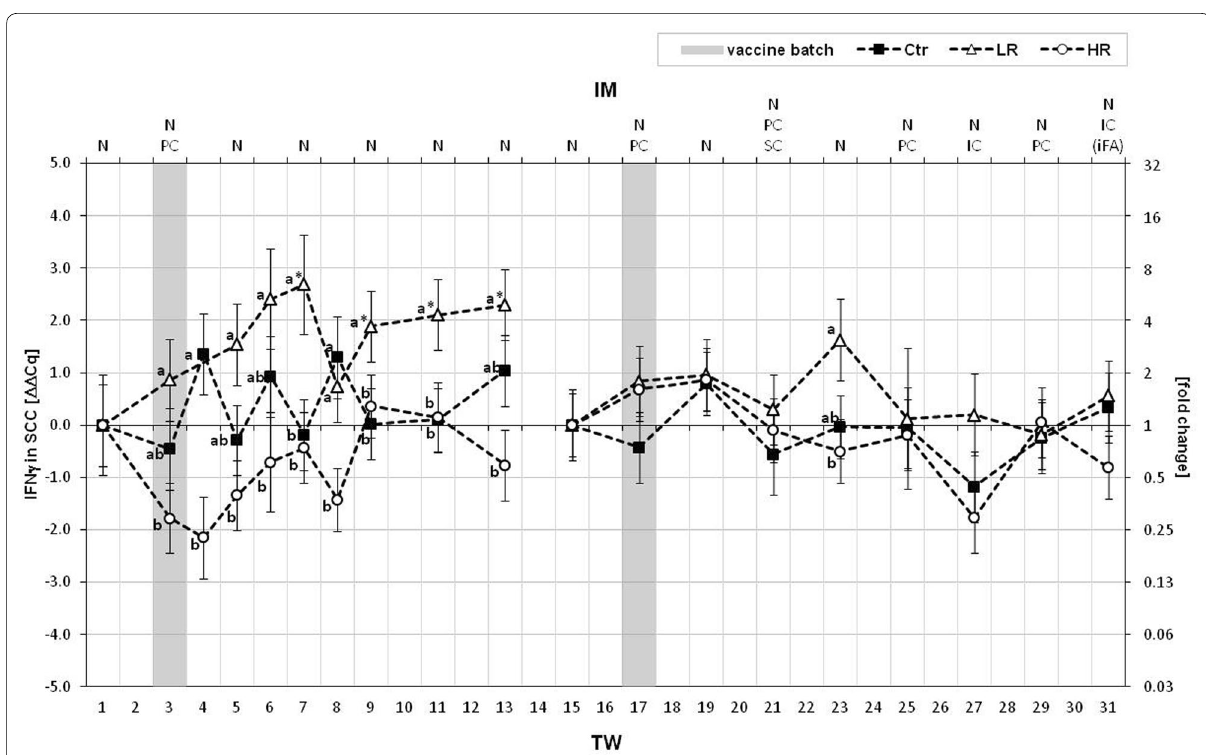
Fig. 4 IFNγ gene expression in SCC. The Y-axis shows the ΔΔCq values of IFNγ as LSM SD and the corresponding fold changes for the control ± (“Ctr”, n 5) and the treated animal groups (“LR”, low responder cows, n 4; “HR”, high responder cows n 5). The 31-week treatment period (TW) is = = = depicted on the lower X-axis. The immunization (IM) specified by the routes of vaccine application [nasal (N), percutaneous (PC), subcutaneous (SC) and intracutaneous (IC)] per TW is illustrated by the upper X-axis. Incomplete Freund’s adjuvant (iFA) was only once part of the MucoCD - I vaccine in TW 31. The gray bars in TWs 3 and 17 highlight the times of the first uses of vaccine batches A and B, respectively. During the treatment periods with both vaccine batches and the particular TW before the first use of vaccine batch A or B, substantial differences within the same group are marked by asterisks ( p < 0.05). Lower case (a, b, c) indicate evident differences ( p < 0.05) between the groups on the same